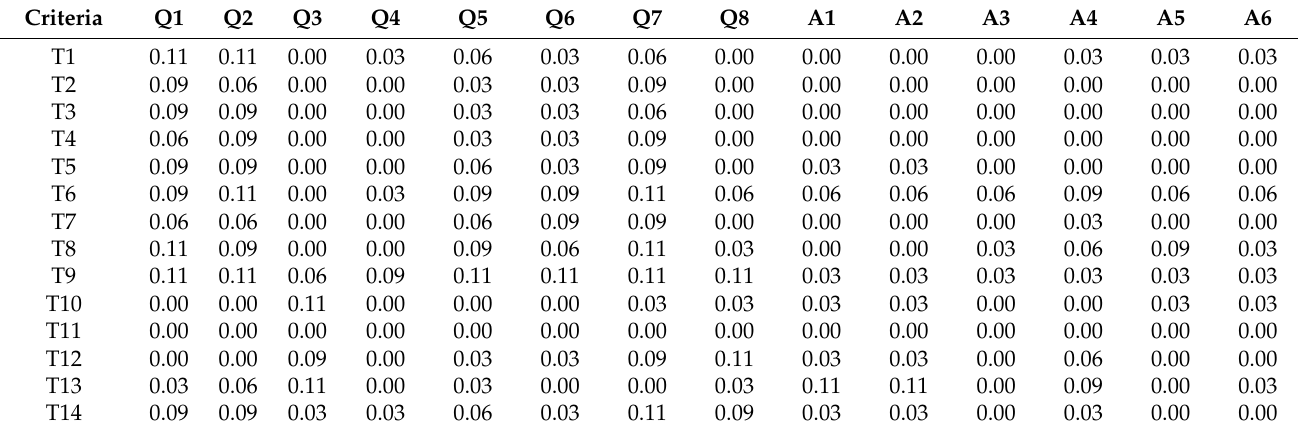
Table 2. Matrix of indirect impact of PV criteria. Own study.